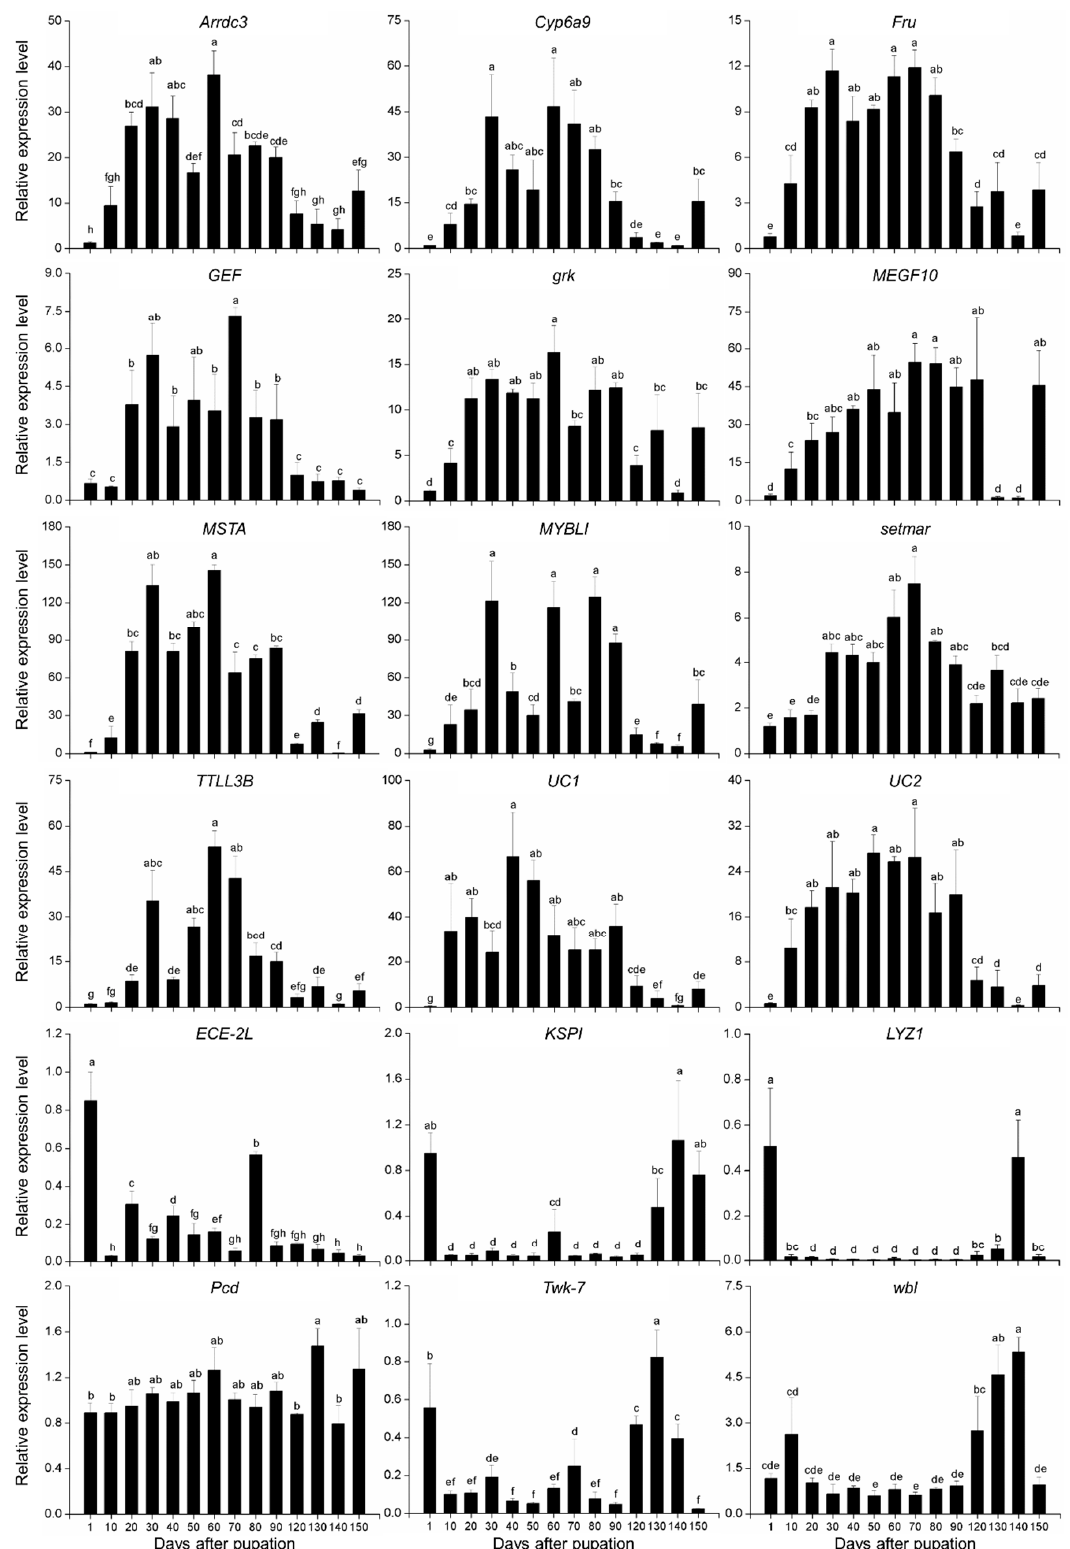
Figure 2. Relative expression levels of 18 putative diapause-associated genes throughout pupal stage of B. minax . For each gene, the relative expression level was calculated against a replicate of newly-formed pupae (1 d after pupation) according to the 2 −ΔΔ Ct method. Different letters indicate significant differences ( p < 0.05).